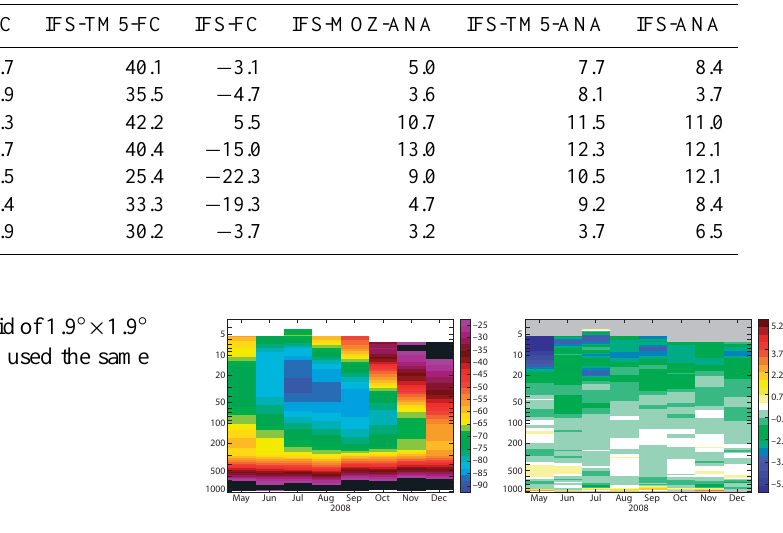
Fig. 4. Monthly mean of observed temperature profiles (left, in ◦ C, y-axis pressure inhPa) and respective forecast errors (right, in K) over Neumayer station for the period from May to December 2008. Blue colours indicate low values and red colour high